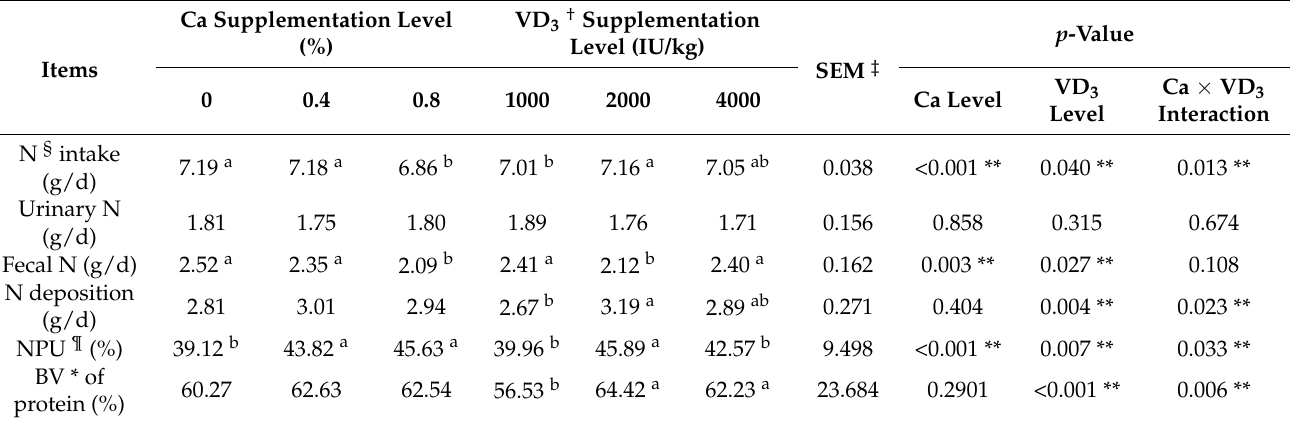
Table 4. Effects of dietary Ca and VD 3 supplemental levels on N metabolism in growing blue foxes (LS means ± SEM).